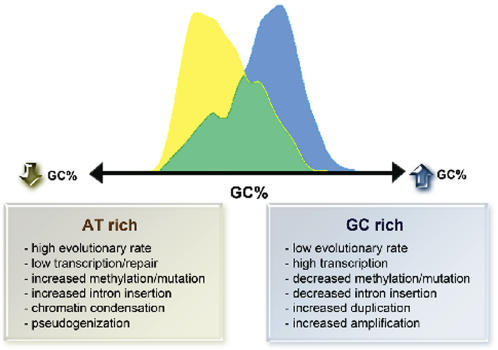
Model of human genomic evolution, proposing the development of a structural split in GC content based on the association of methylation-dependent mutation with transcriptional repression, chromatin condensation, reduced repair and intron insertion.